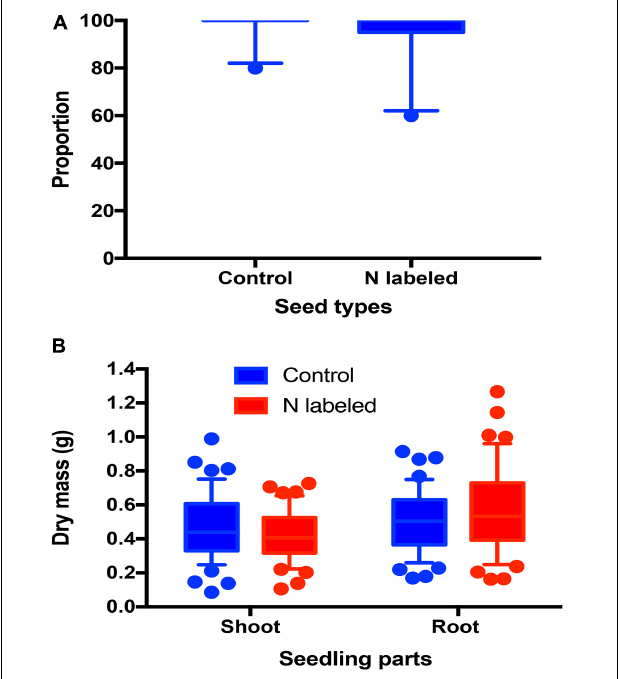
FIGURE 3 | Effects of xylem injection of 15 NH 4 Cl and K 15 NO 3 on acorn germination rate (A) and shoot and root dry masses (B) .